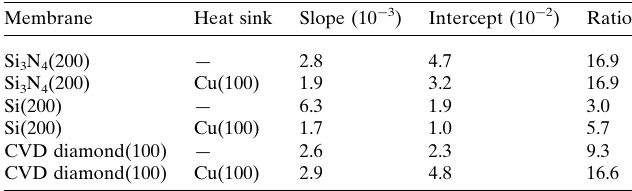
Table 1 Slope and intercept and their ratio (intercept/slope) fitted from the integral of the absolute change in XAS as a function of the pulse number in the train shown in Fig. 11. The samples are 20 nm Ni film capped with 2 nm MgO and grown on different sample stacks listed below with thickness in nm.